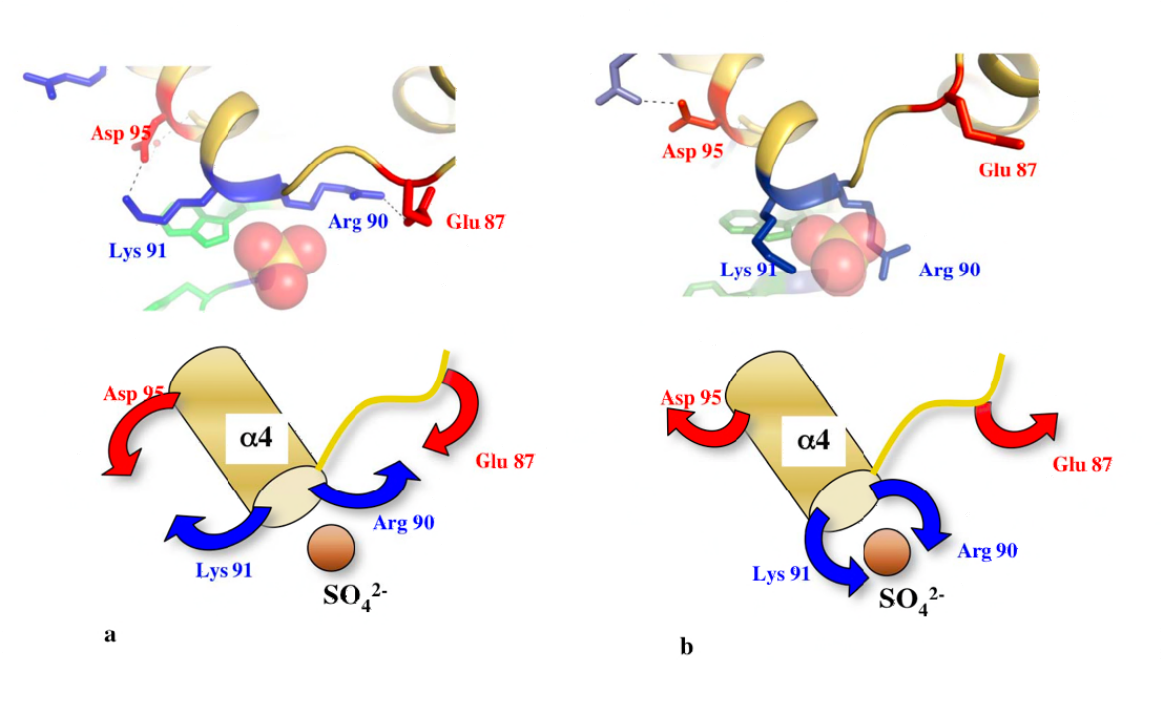
Figure 7. Structural rearrangements found at the interface between the globular domain and the extension of L20 of A. aeolicus . (a) The partially unfolded form is stabilised by the formation of two salt bridges that link two evolutionary conserved basic residues arg 90 and lys 91 to asp 95 and glu 87 located within the globular domain. (b) In the folded form, the two salt bridges are disrupted and the side chains of arg 90 and lys 91 embrace a sulfate ion. The sulfate ion occupies a position identical to a phosphate group of the H40/41 helix within the 50 S subunit of the eubacterial ribosome. In the unfolded form (a), due to the polarity of the helix ( α 4), the sulfate ion is also maintained at its N-ter